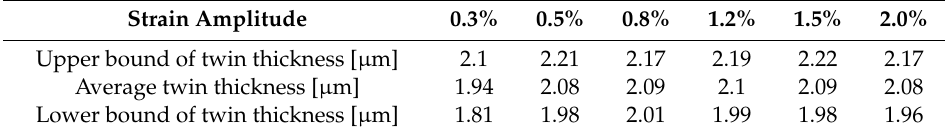
Table 5. Distribution of the relationship between strain and average twin